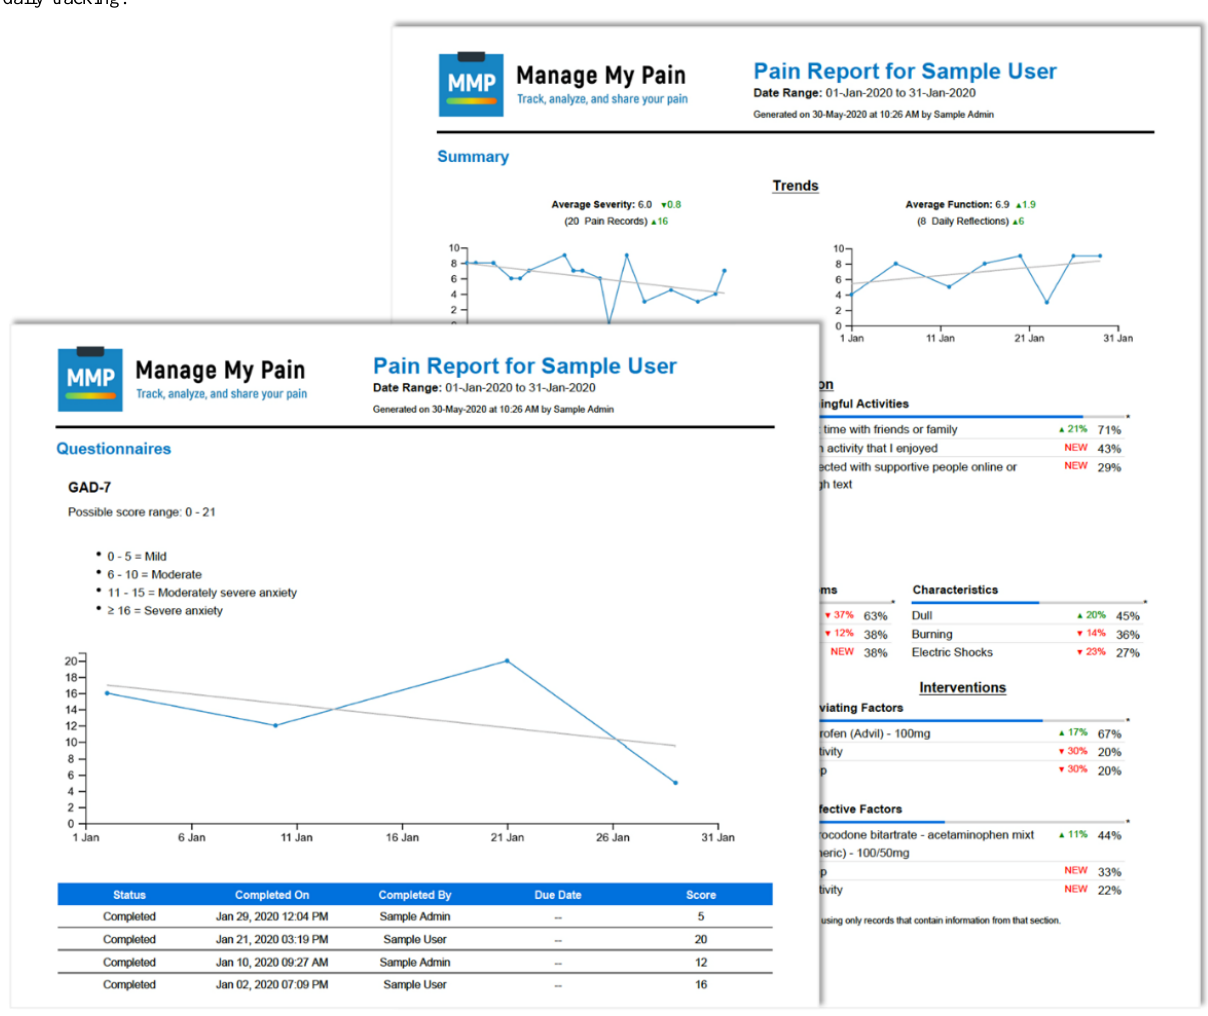
Figure 2. Sample clinician-facing report produced by Manage My Pain that contains scored responses to validated measures as well as a summary of the daily